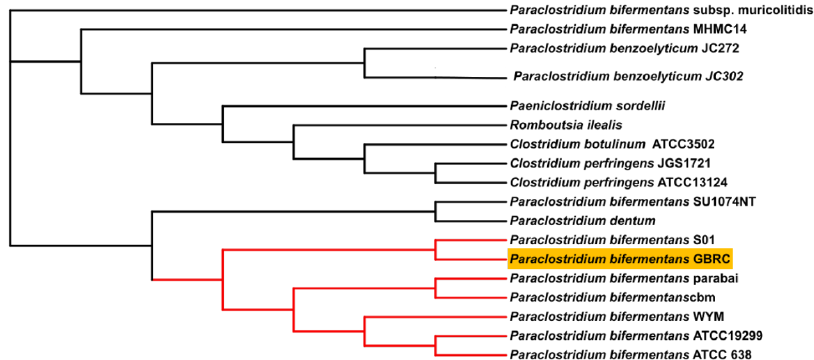
Figure 3. Phylogenetic tree reconstructed with the neighbor-joining method based on the whole genome sequence of the Paraclostridium bifermentans strains and related genus of Paraclostridium. P. bifermentans GBRC showing the phylogenetic relationship with the related species.